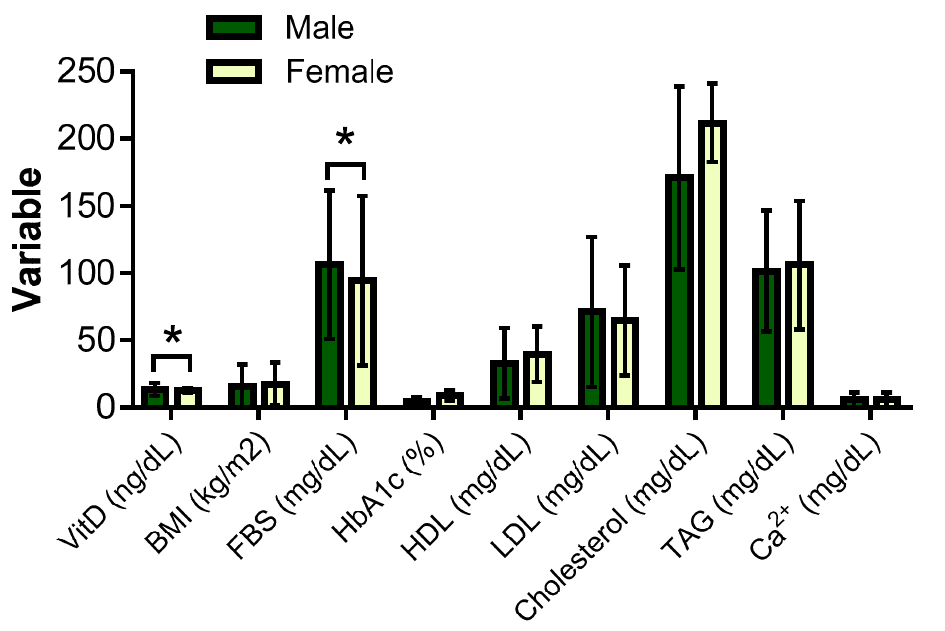
Figure 1. VitD status and other health indicators in Libyan adults according to sex. N = number; % = percentage within population; BMI = body mass index; FBS = fasting blood sugar; HbA1c = glycosylated hemoglobin; HDL = high-density lipoproteins; DL = low-density lipoproteins; TAG = triglycerides; Ca 2+ = calcium; VitD = vitamin D. (*) indicates p < 0.05.